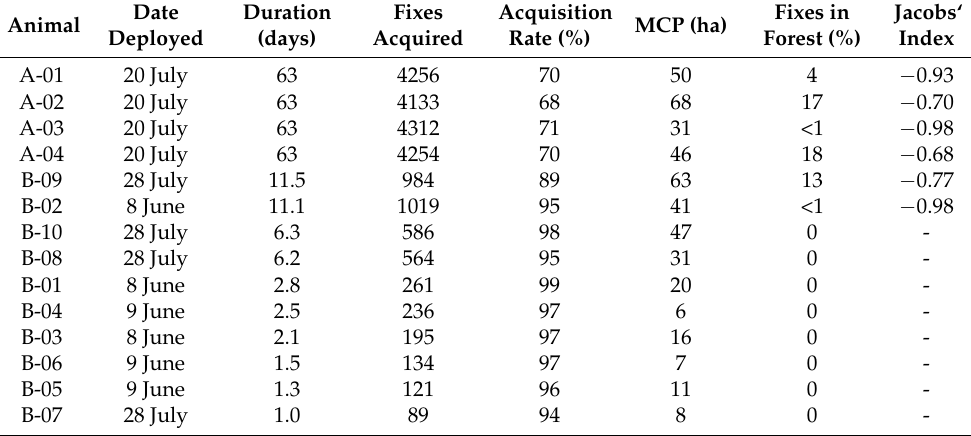
Table 1. Technical details, area of activity, forest usage and selectivity (Jacobs’ index) of individual eastern grey kangaroos at Heritage Park, Coffs Harbor, New South Wales, Australia. Animals beginning with ‘A’ carried GPS collars and those beginning with ‘B’ carried i-gotU GPS devices. Jacobs’ index values provide an indication of selectivity from − 1 (strong avoidance) to +1 (strong